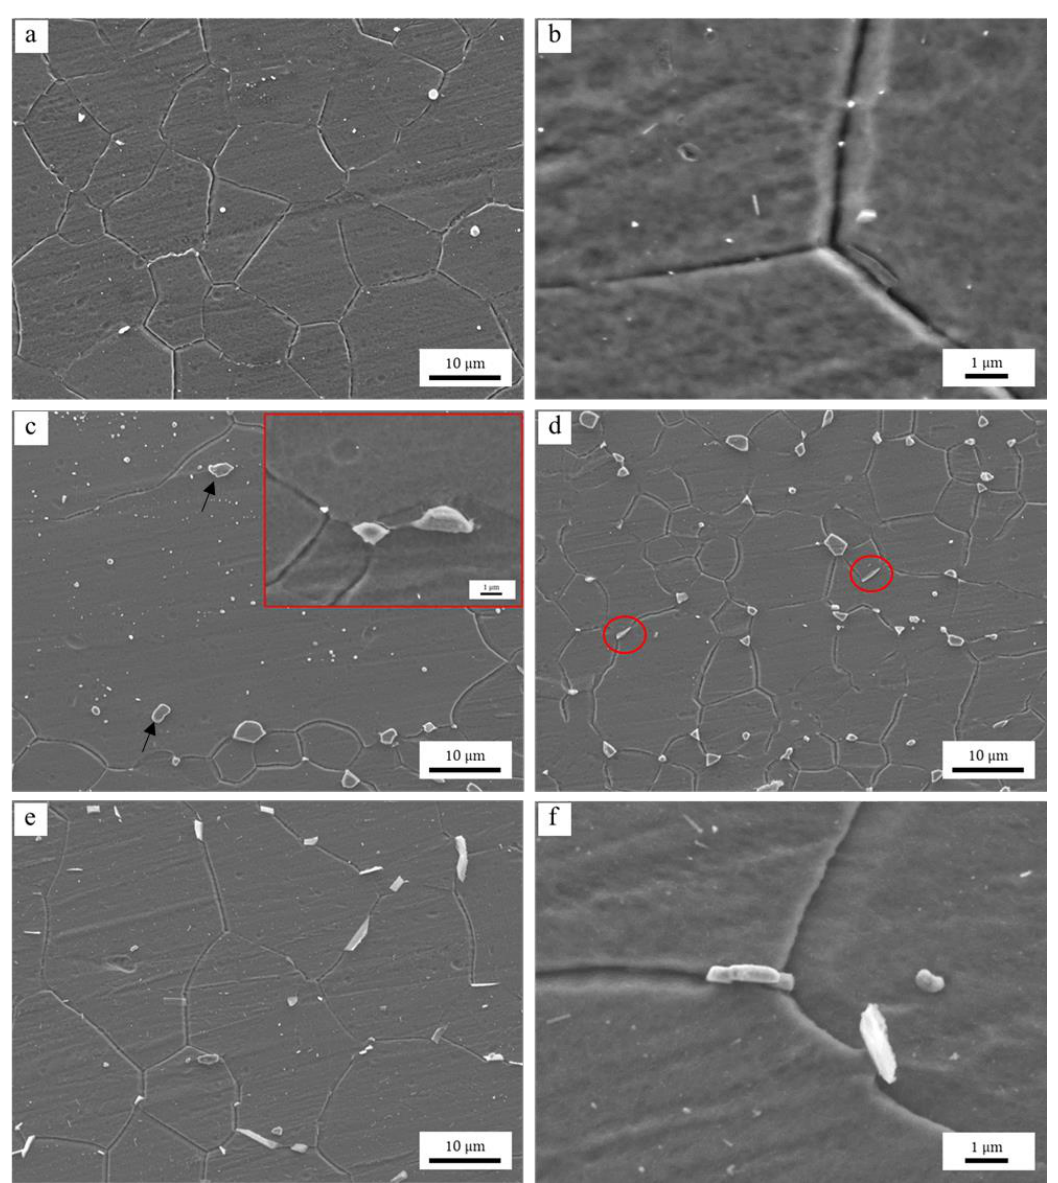
Figure 12. SEM images of AZ61 annealed at ( a , b ) 300 °C, ( c , d ) 350 °C, and ( e , f ) 400 °C for 72 h. The red rectangle in ( c ) is an enlarged view of the second phase particles at the grain boundary between the abnormal grain and the normal grain. The black arrows and red circles refer to the large granular and lamellar second phase particles in ( c ) and ( d ), respectively.